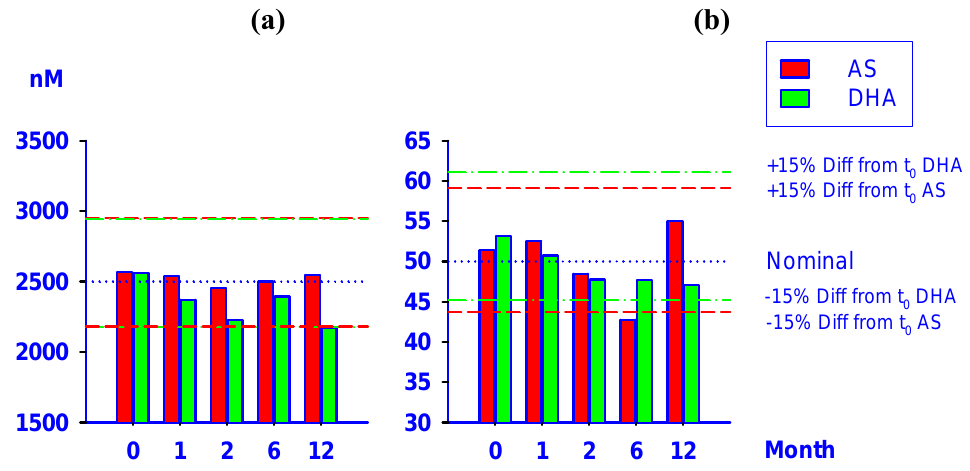
Figure 8. Stability of AS and DHA in plasma at (a) 2500 nM and (b) 50 nM when stored at - 80 °C over 12 months. Mean values based on six replicate analyses with dashed lines showing ±15% differences compared to initial concentration measured at time zero (t